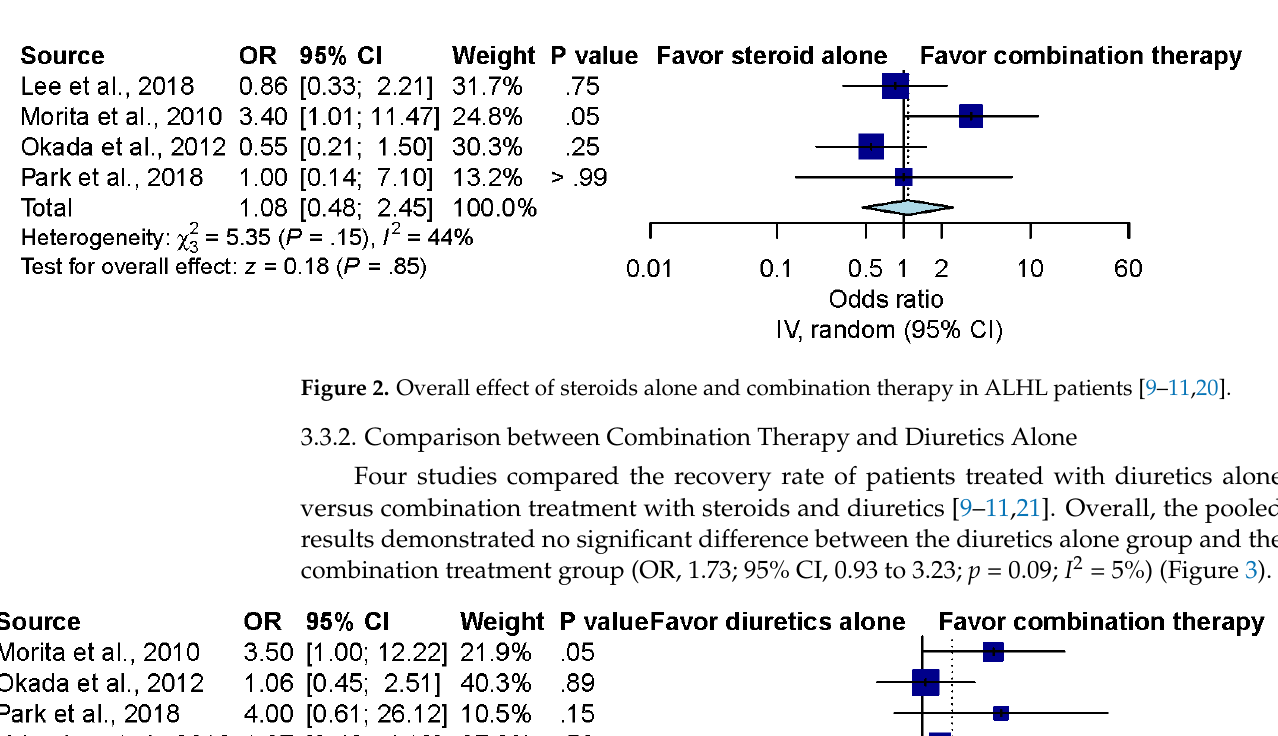
Figure 3. Overall effect of diuretics and combination therapy in ALHL patients [9–11,21].